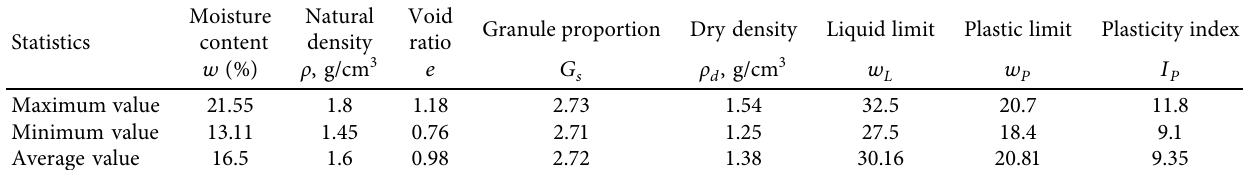
Table 1: Experimental statistics of the physical and mechanical properties of the soil